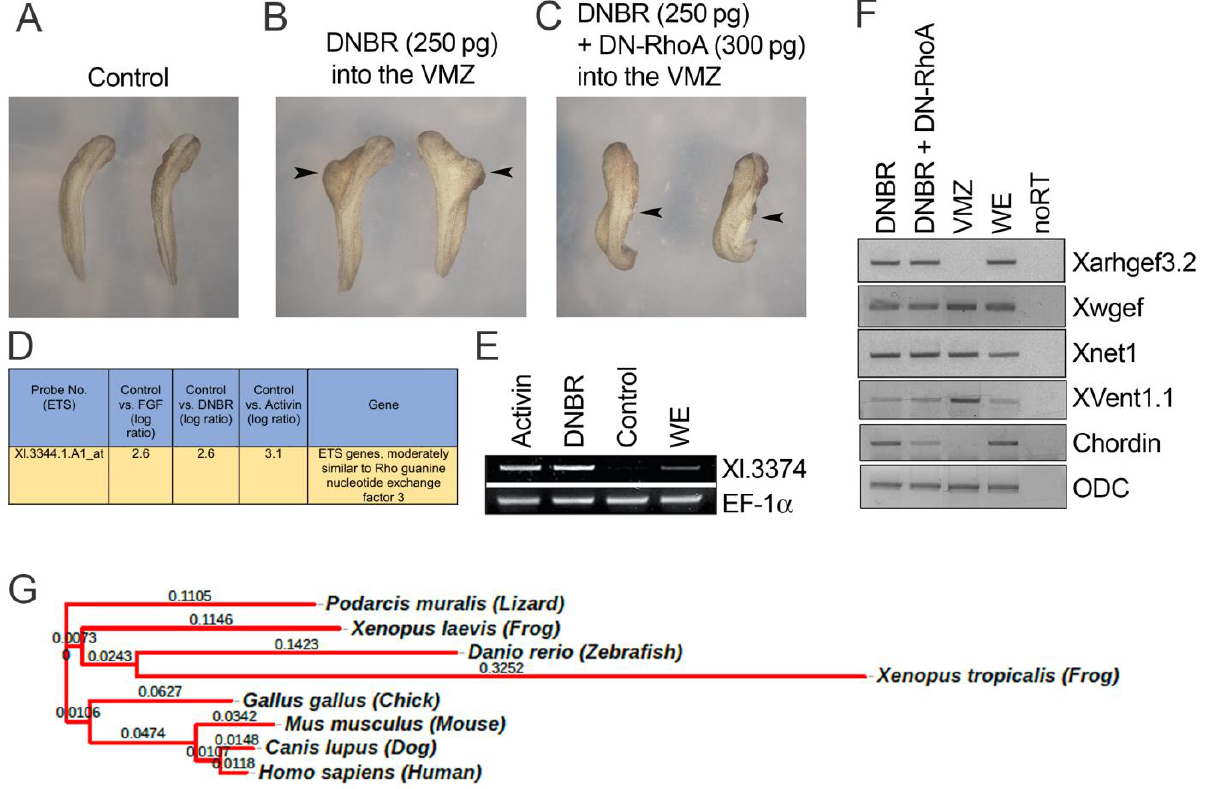
Figure 1. Bmp inhibition induced a secondary axis and requires RhoA activation of gastrulation cell movement in the VMZ. Identification of Xarhgef3.2 . ( A – C ) The embryos were co-injected with 500 pg of DNBR mRNA with or without 300 pg of DN-RhoA at the four-cell stage into the VMZ. The noninjected control and injected embryos were analyzed at the 28 – 30 stage. ( D ) Microarray analysis data showed that Xl.3374.1.1A_at is induced by DNBR (500 pg/embryo), activin (25 ng/mL), and bFgf (100 ng/mL) at stage 11. ( E ) The microarray data were confirmed by RT-PCR at stage 11; EF-1a was used as a loading control. ( F ) The VMZ explants of the embryos (( A – C ) conditions) were dissected at stage 10. RT-PCR was performed to examine the expression pattern of the indicated genes at stage 12. ( G ) Phylogenetic tree created by amino acid sequence comparison of Xarhgef3.2 of the various species shown in the tree.